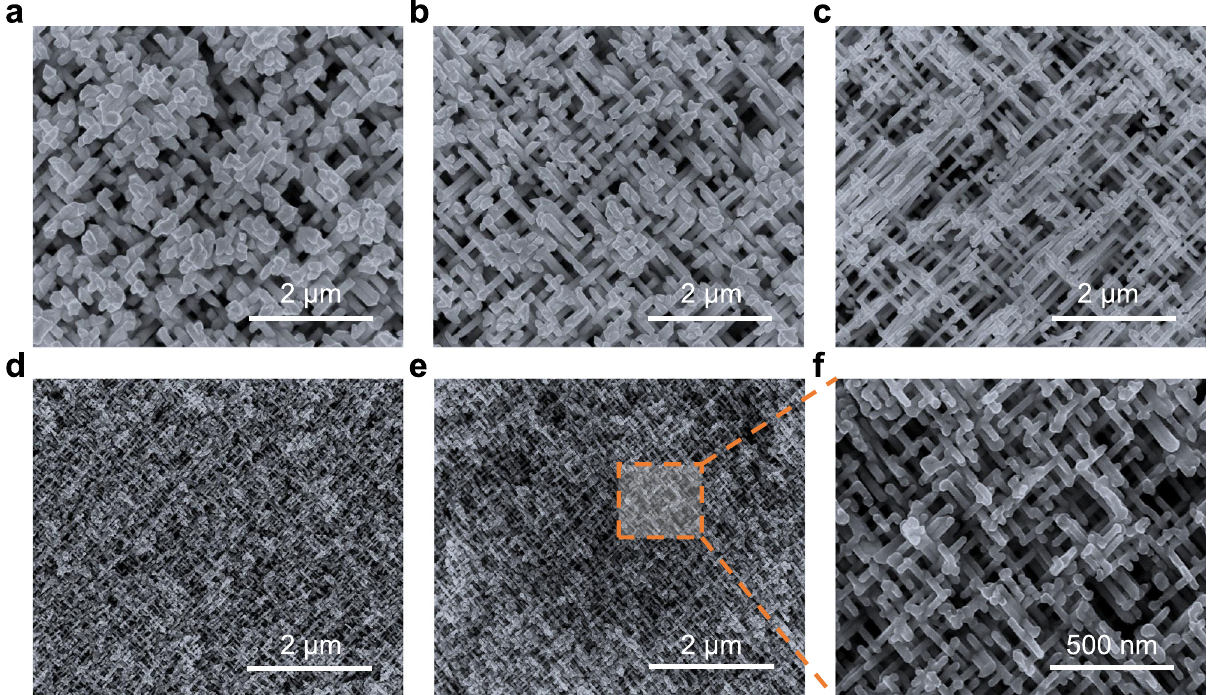
Fig.2|Nanobeamdiametertuning.a – d SEMimagesofgoldquasi-BCCnanolattices. a Au-117 b Au-86 c Au-69 d Au-34,respectively. e Copperquasi-BCCnanolatticeCu- 34. f Magni fi ed SEM image of e